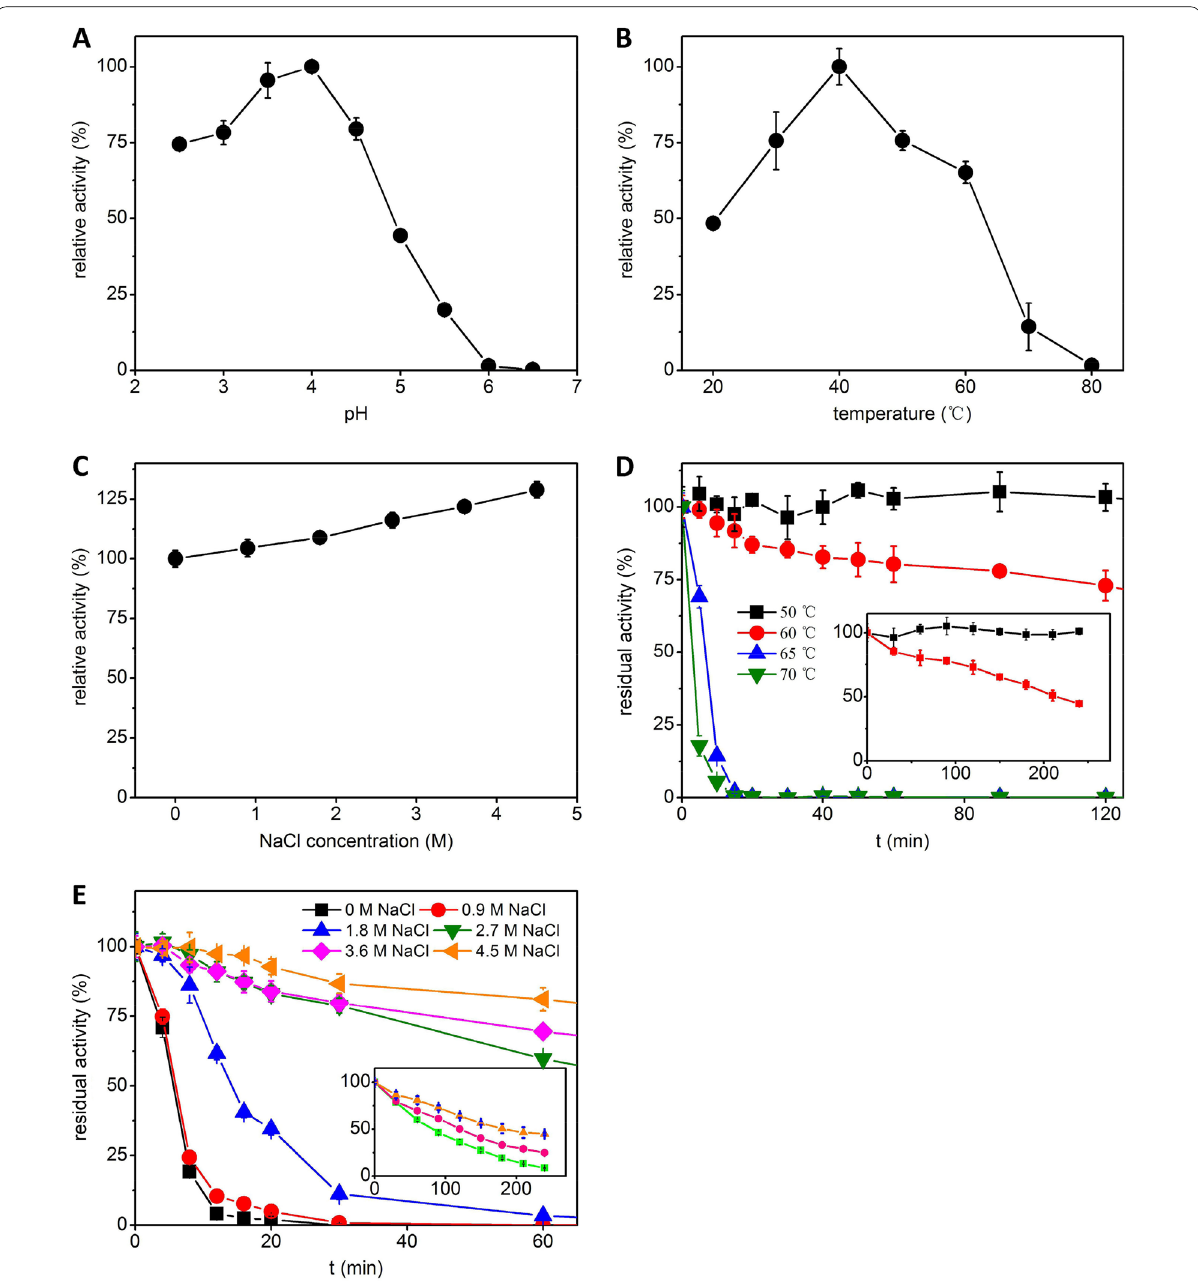
Fig. 2 Enzymatic properties of An EGL. A Influence of pH on the activity at 50 °C in the absence of NaCl. B Influence of temperature on the activity at pH 4.0 in the absence of NaCl. C Influence of salt concentration on the activity at 50 °C pH 4.0. D Thermostability at pH 4.0 in the absence of NaCl. The horizontal axis (incubated time) was expanded in the small graph. E Influence of salt concentration on the thermostability at 65 °C pH 4.0. The horizontal axis (incubated time) was expanded in the small